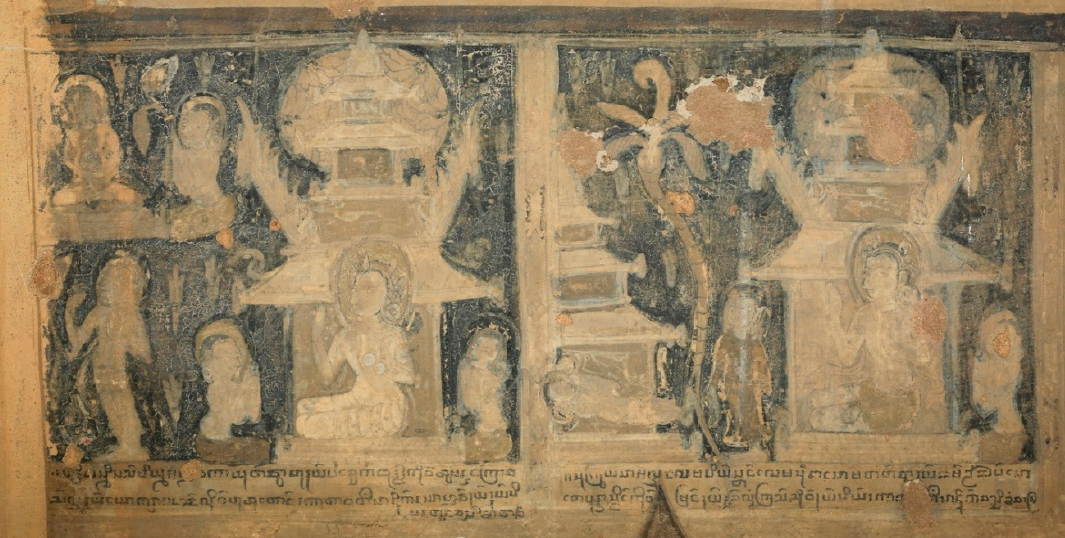
Figure 29. Pagan, Kutha, 13th century. Two Vimana images—the left image concerning a young woman who wished to be reborn as a man, the right one showing the benefits of being in the Buddha’s vicinity, his very sight guaranteeing the lucky mansion inhabitant many years of bliss in the heavens.